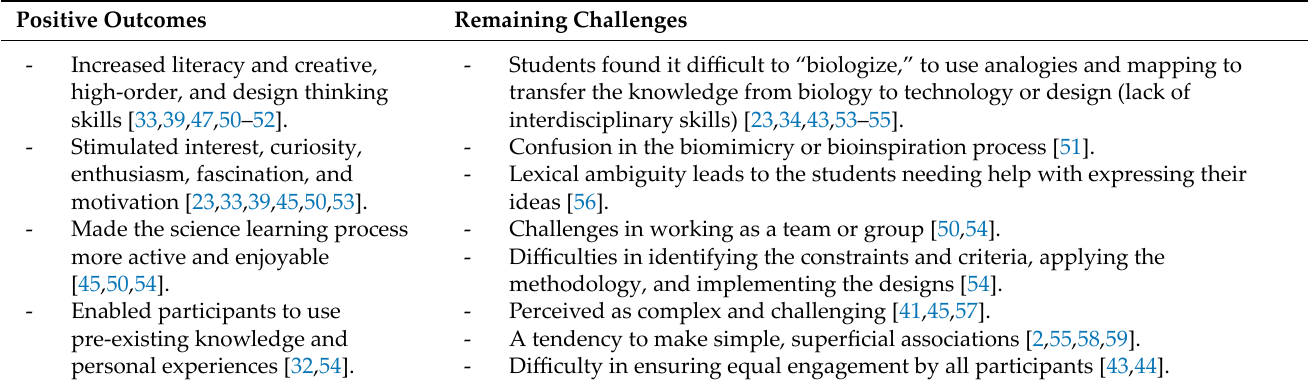
[30,49]. Table 1. Overview of positive outcomes and remaining challenges reported in the literature on teaching biomimetics.